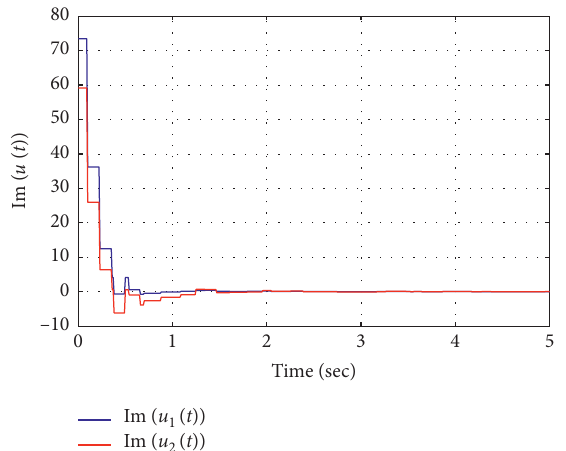
Figure 7: Responses input u ( t ) of the imaginary